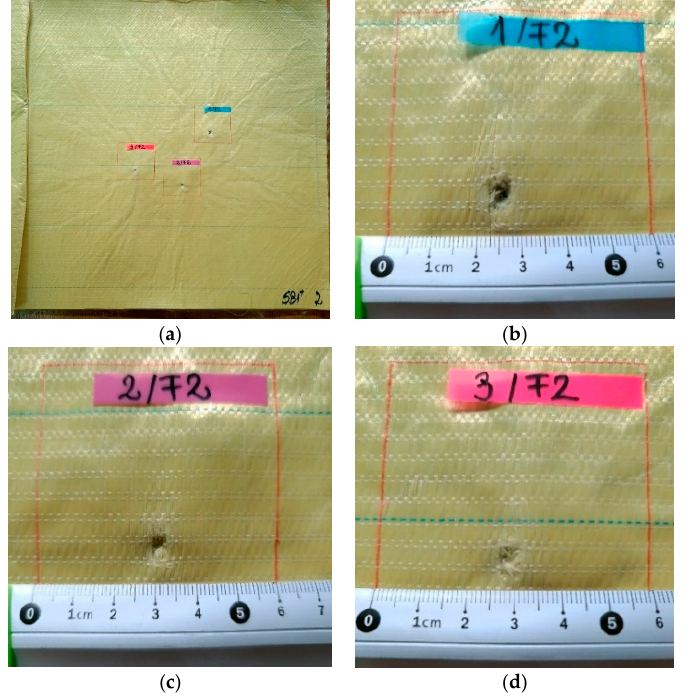
Figure 8. Frontal view of the sample with 12 layers of LFT SB1plus: ( a ) layer 2 (face), with details of the bullet holes of ( b ) fire 1, ( c ) fire 2 and ( d ) fire 3.